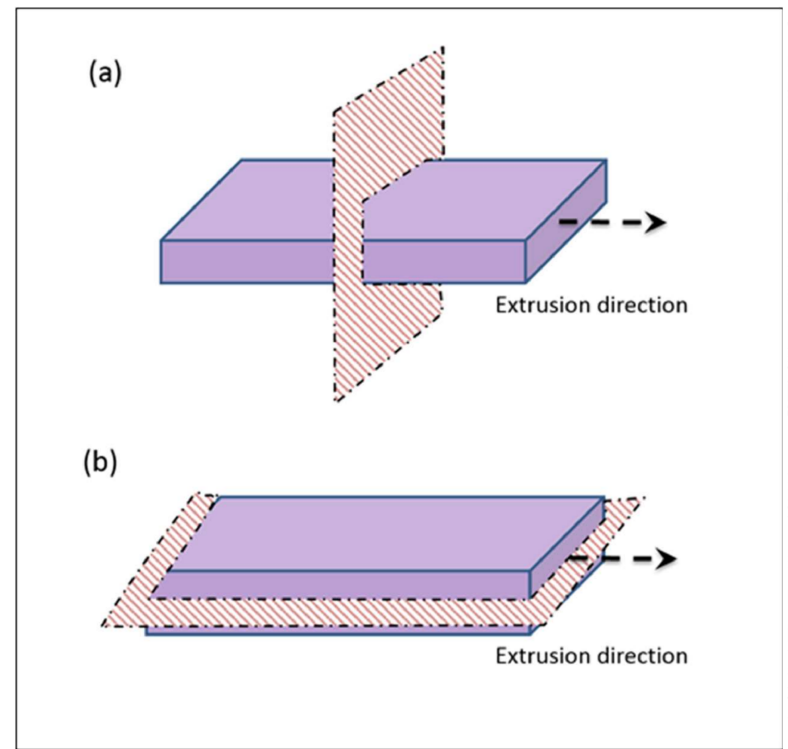
Figure 1. Cryo-fracturing of specimens ( a ) perpendicular to the direction of extrusion and ( b ) along the direction of